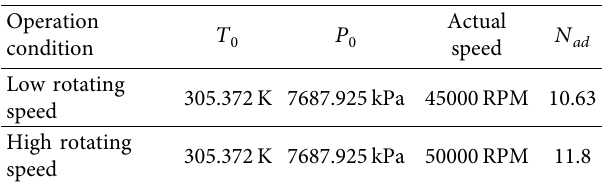
Figure 12: Computational grid of the SNL compressor. (a) Impeller mesh and (b) vaned diffuser mesh. Table 2: Validation case operating conditions.